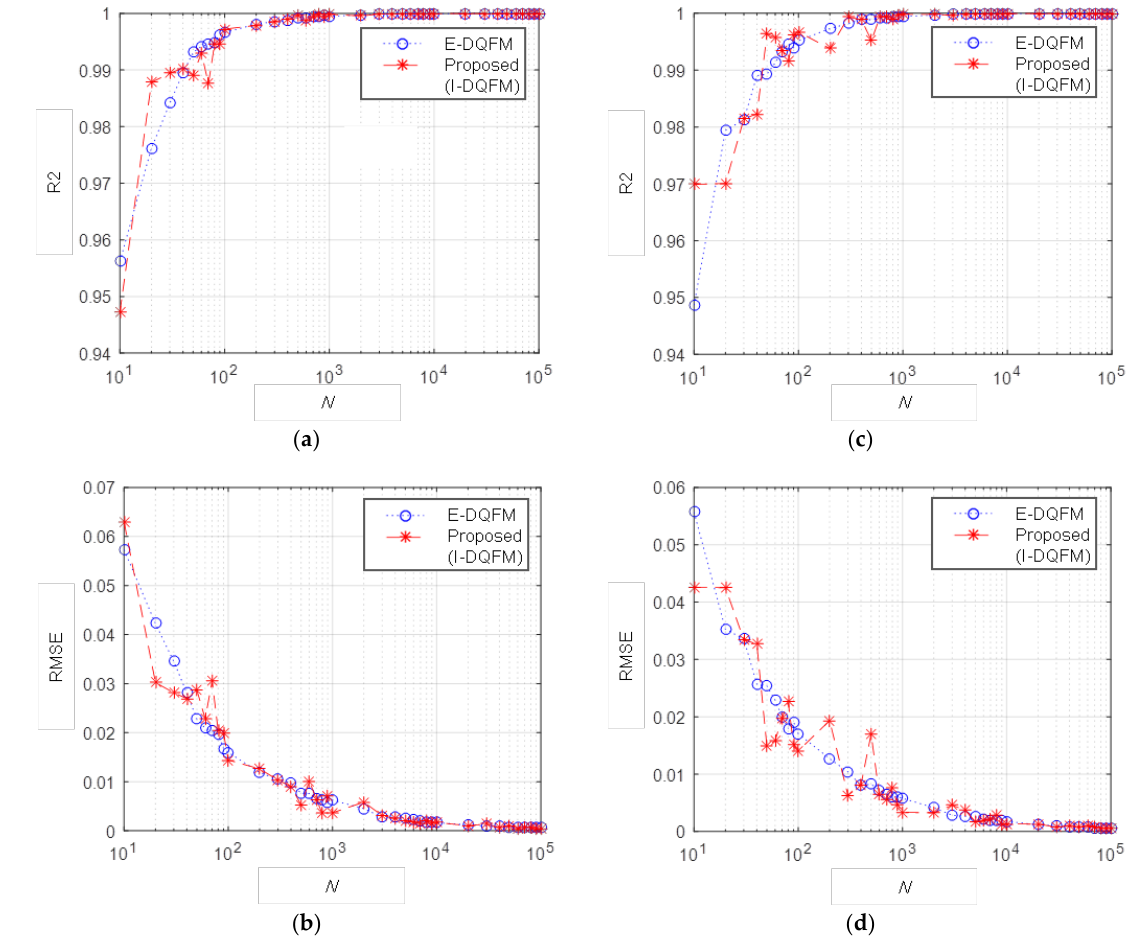
Figure 7. The R2 and RMSE comparison of E-DQFM and proposed method according to the number of samplings number “ N ” regarding the C1 ∩ C2 example: ( a ) R 2 for independent case; ( b ) RMSE for independent case; ( c ) R 2 for fully correlated case; ( d ) RMSE for fully correlated case.